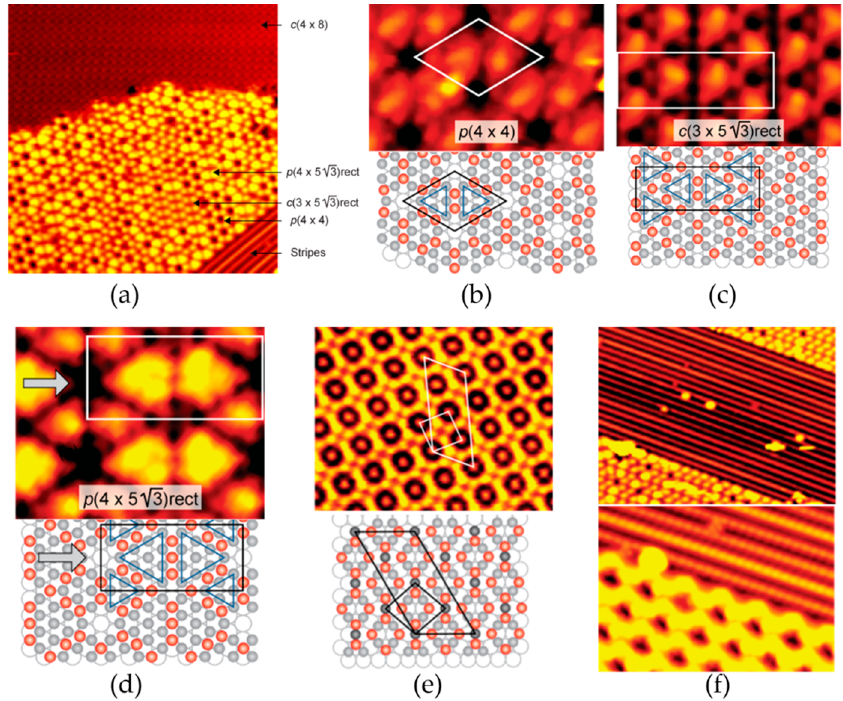
Figure 3. ( a ) STM image of an Ag (111) sample exposed to 5 × 10 − 8 Torr atomic oxygen for 40 min at 500 K sample temperature. STM images and experimentally derived structures of ( b ) p (4 × 4) phase, ( c ) c (3 × 5 √3 )rect, ( d ) p (4 × 5 √3 )rect, and ( e ) c (4 × 8) phase. Red/dark gray spheres represent the oxygen/second layer silver, (medium) gray represent the overlayer silver, and the open spheres represent the Ag (111) substrate atoms. ( f ) 200 × 200 Å and 75 × 75 Å for STM images of the stripe phase.